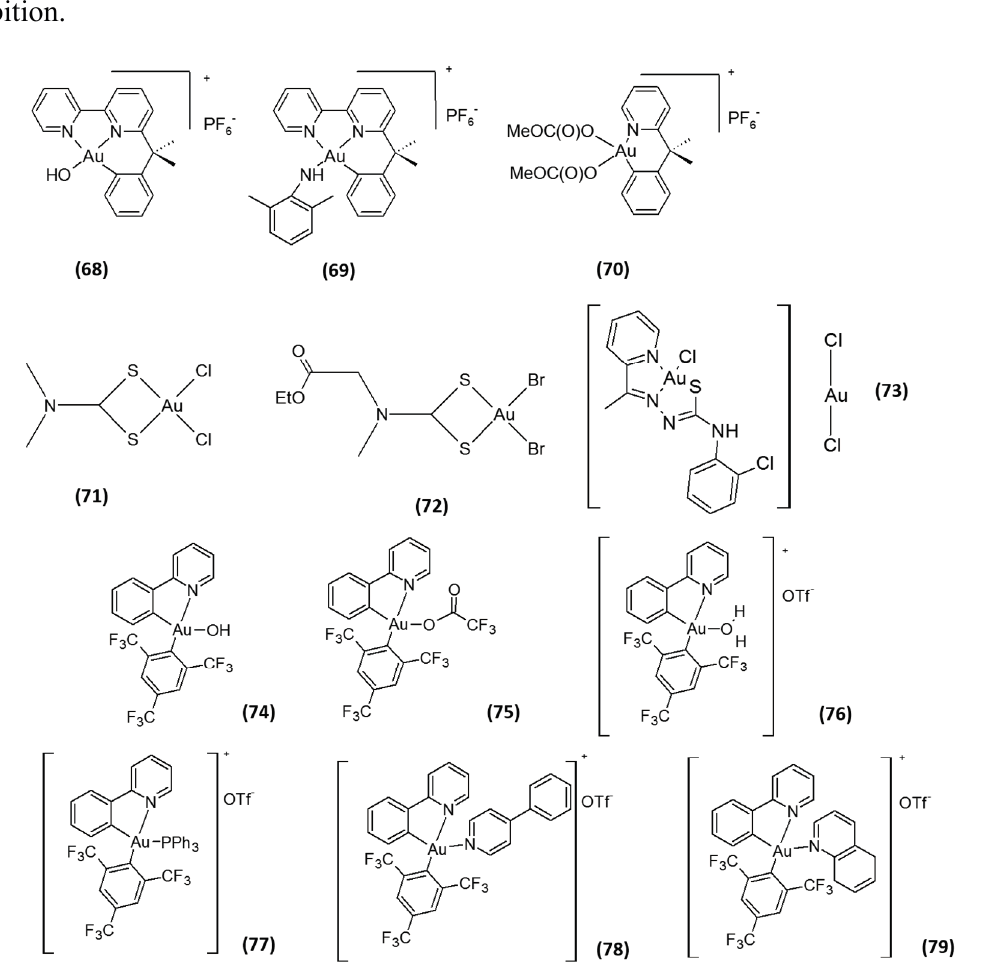
Figure 4. Structures of gold(III)-based